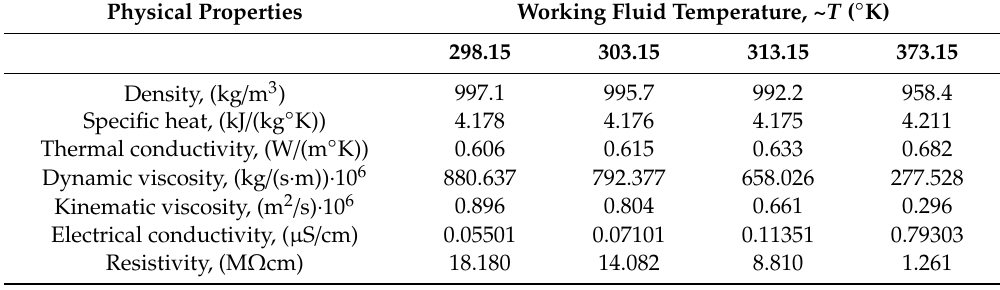
Table 6. Selected physical properties of the deionized water during saturation pressure.